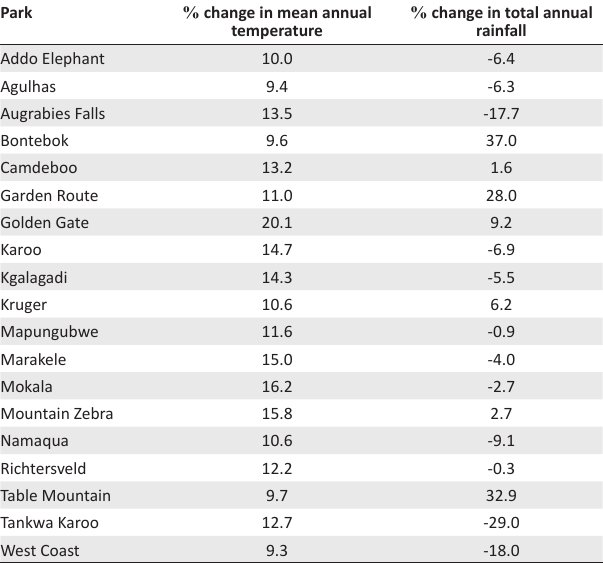
TABLE 1: Projected percentage change in mean annual temperature and total annual precipitation for each park from historic average (1960–1990) to mid- century (2040–2060), by using Coupled Model Inter-Comparison Project